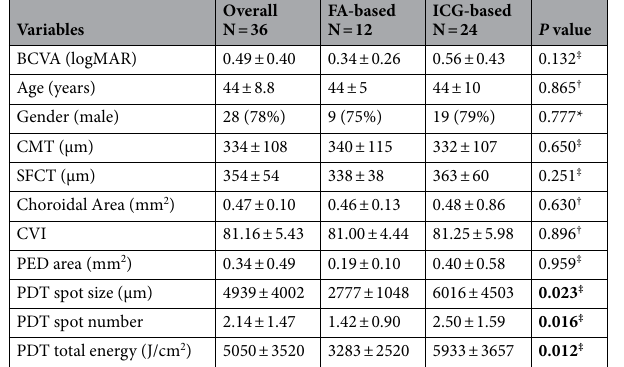
Table 1. Baseline characteristics. † independent sample t test; ‡ Mann-Whitney U test; *chi square test. CMT Central macular thickness, SFCT Subfoveal choroidal thickness, CVI Choroidal vascular index;